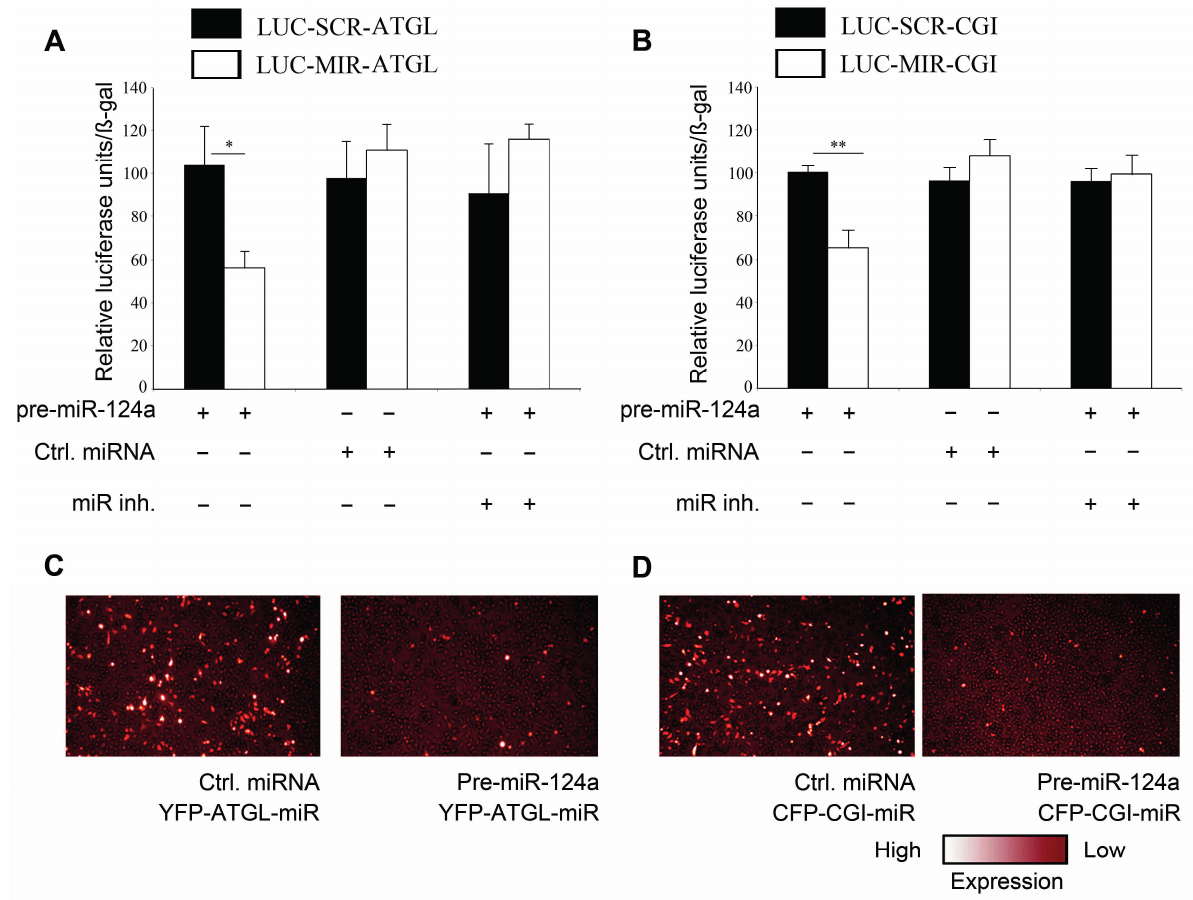
Figure 2. miR-124a interacts with the 3'UTR of Atgl (mRNA) and Cgi-58 (mRNA). ( A ) Luciferase activity (relative units, normalized to β -gal activity for transfection normalization) measured after co-transfection of HeLa cells with either LUC-MIR-ATGL or LUC-SCR-ATGL with control pre-miRNA or pre-miR-124a and miR-124a inhibitor as indicated; ( B ) LUC-MIR-CGI or LUC-SCR-CGI was co-transfected into HeLa cells together with either miR-124a or control pre-miRNA and miR-124a inhibitor. β -gal containing plasmid was transfected for transfection normalization. Values are presented as relative luciferase units normalized to β -gal activity; ( C , D ) HeLa cells were co-transfected with YFP-ATGL-miR ( C ) or CFP-CGI-miR ( D ) and either pre-miR-124a or control pre-miRNA. Data are shown as average ± standard deviation and represent three independent experiments. ** p < 0.01, * p <